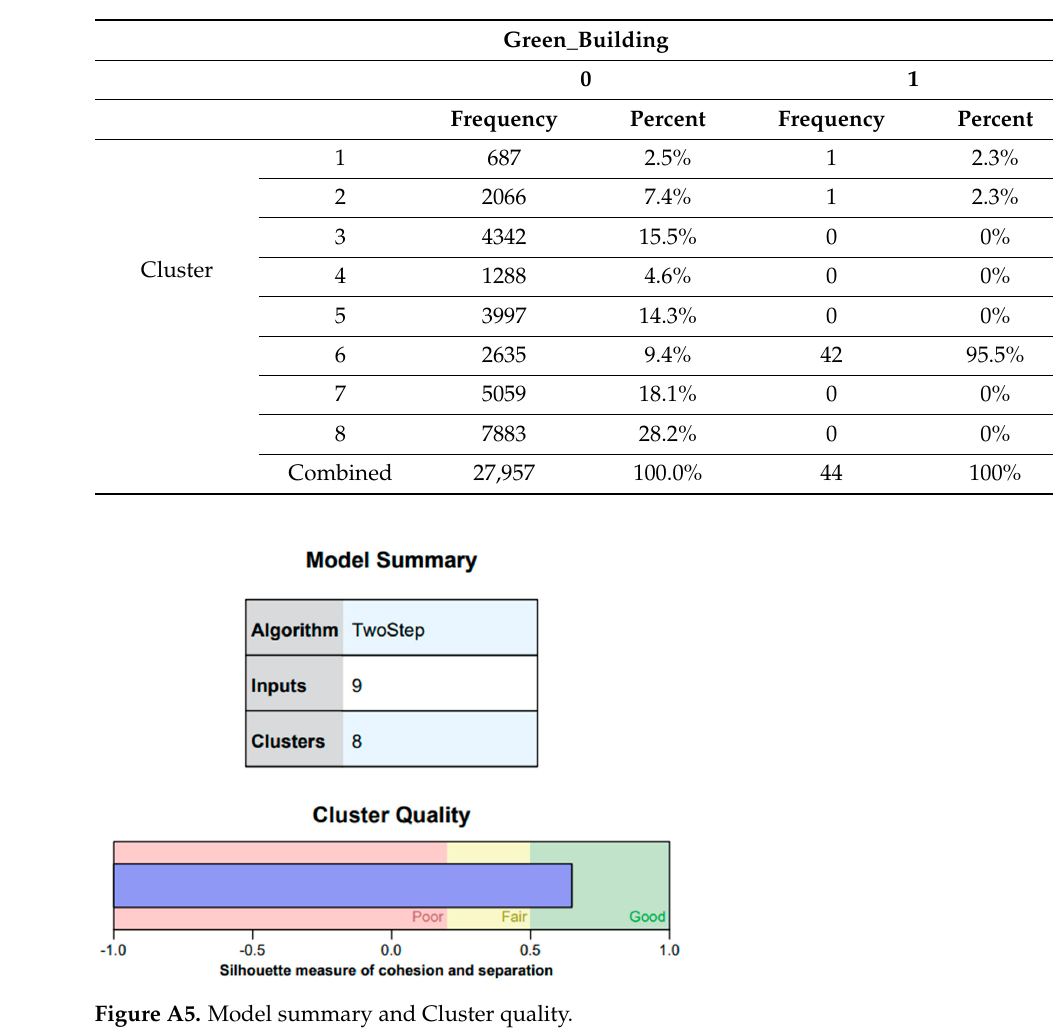
Figure A5. Model summary and Cluster quality.